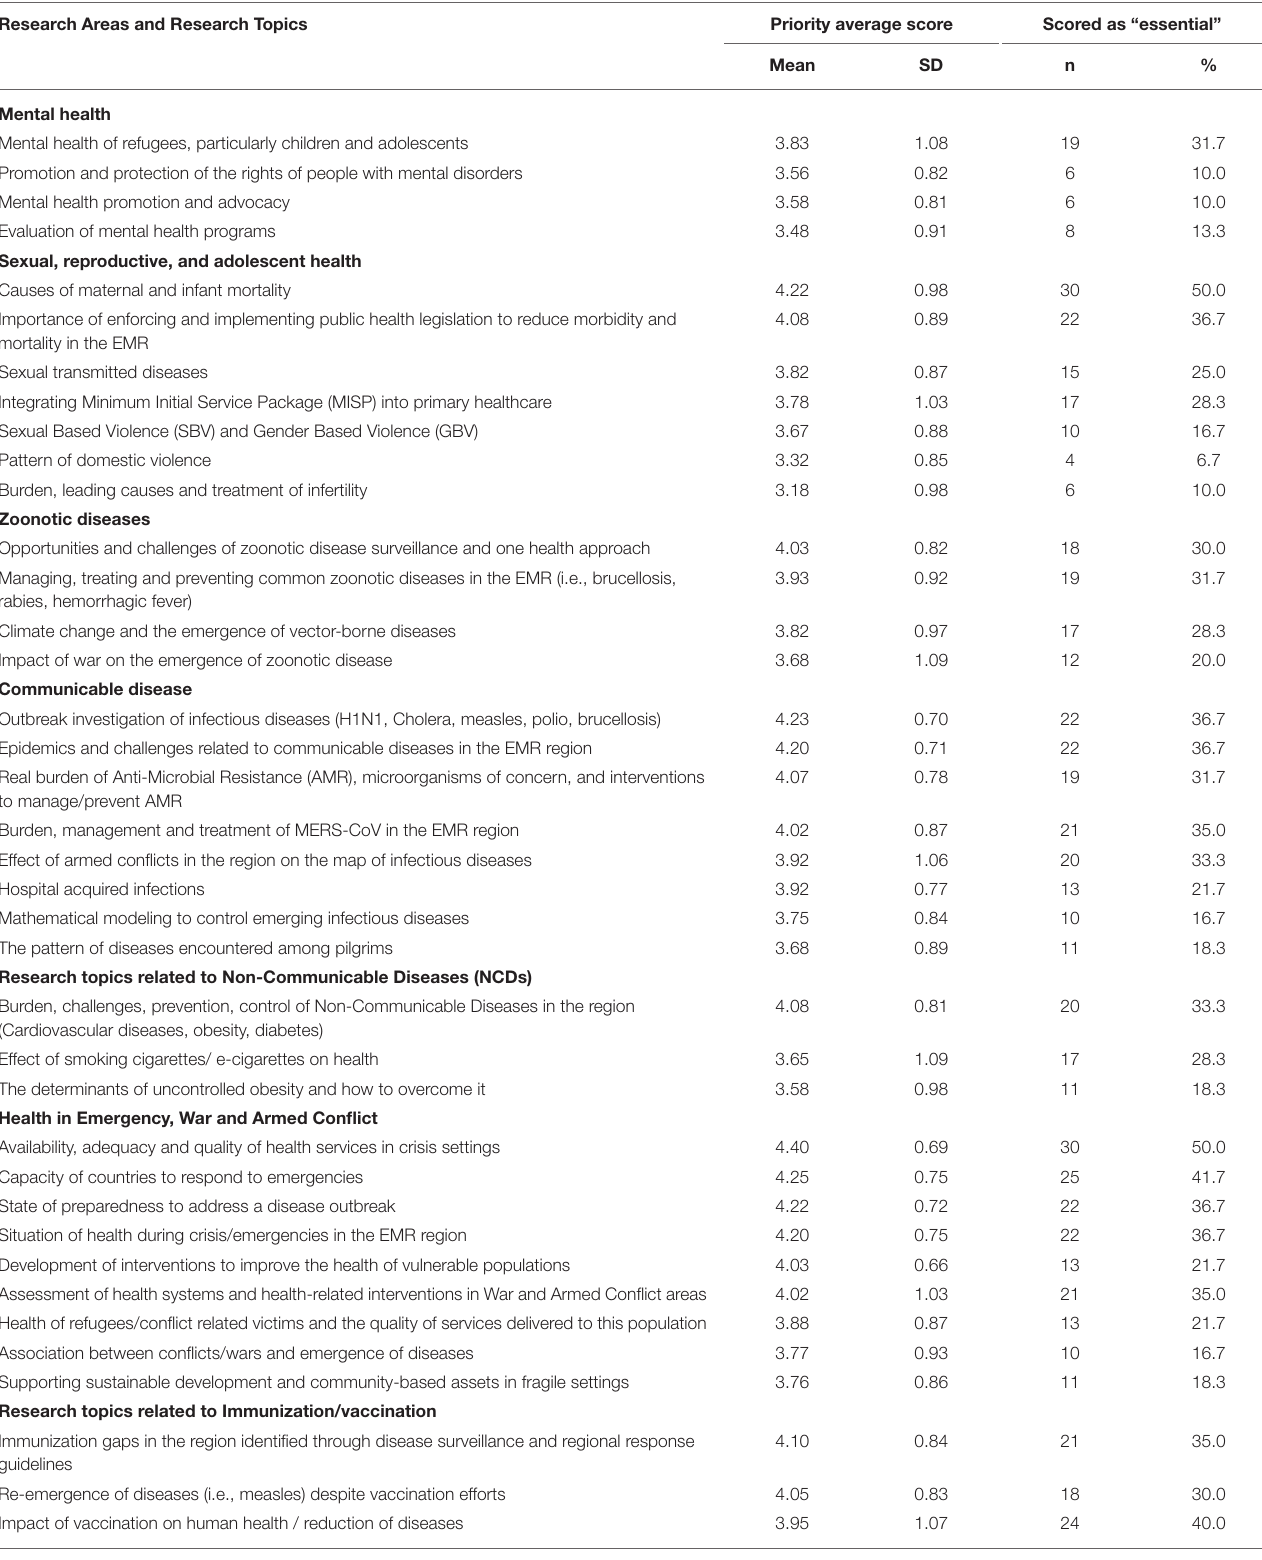
TABLE 1 | The priority scoring of 54 research topics categorized according to research